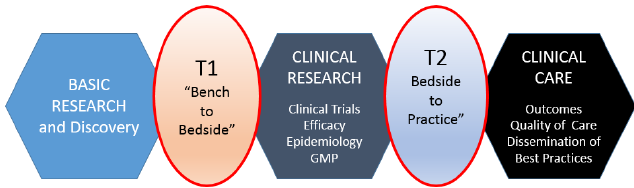
Figure 1. Schematic transitions from the “Bench to Bedside” ( T1 ) and “Bedside to Practice” ( T2 ) translational medical research and development model. The process of invention and then development is bidirectionally promoted by academic inquiry, as well as astute clinical observations. “Bench to Bedside” is catalyzed by first principles inquiry and the “Bedside to Bench” direction is catalyzed by a clinical observation and an articulated “if only I had . . . .” to solve this clinical problem or fill this unmet need in my practice of medicine.